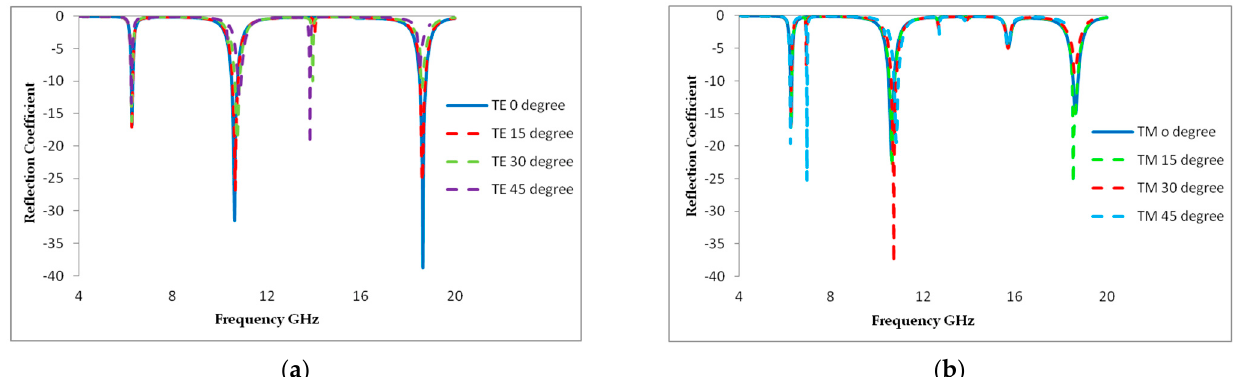
Figure 5. Reflection coefficient results of proposed MA at different incidence angles: ( a ) TE and ( b ) TM.